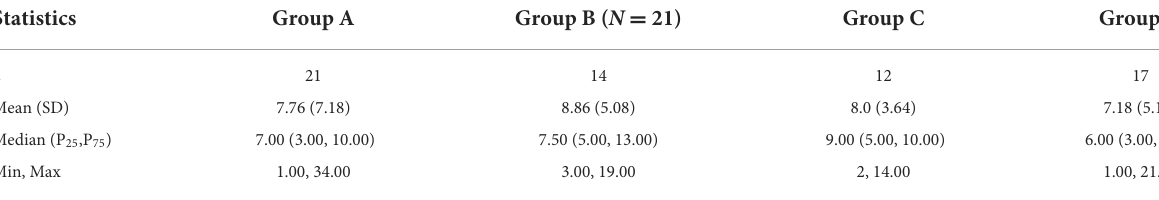
TABLE 5 Comparison of ODI scores between groups before treatment.